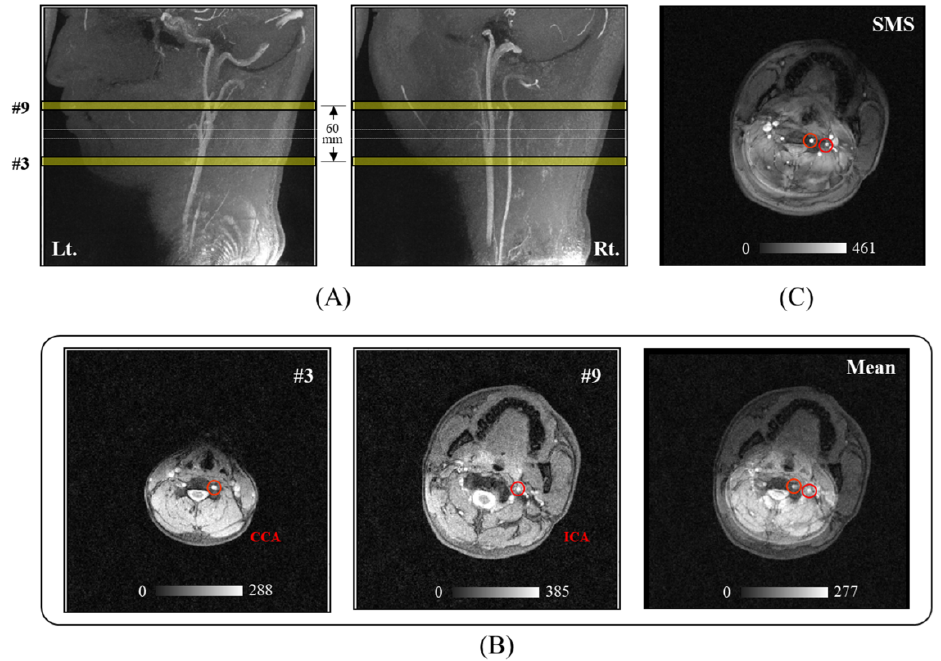
Figure 3. Human images comparing the SMS-K image with the mean GRE image of two selected slices. ( A ) Maximum-intensity projection images for CCA and ICA acquired with 3D TOF MRA. ( B ) GRE images and the mean image of the 3rd and 9th slices. ( C ) SMS-K image acquired simultaneously on the 3rd and 9th slices. Red circles indicate the target vessels for further analysis. Gray scale bars indicate the signal intensity. Abbreviations: 3D TOF MRA, 3-dimensional time-of-flight magnetic resonance angiography; CCA, common carotid artery; GRE, gradient echo; ICA, internal carotid artery; Lt, left; Rt, right; SMS-K, simultaneous multi-slice keyhole technique.